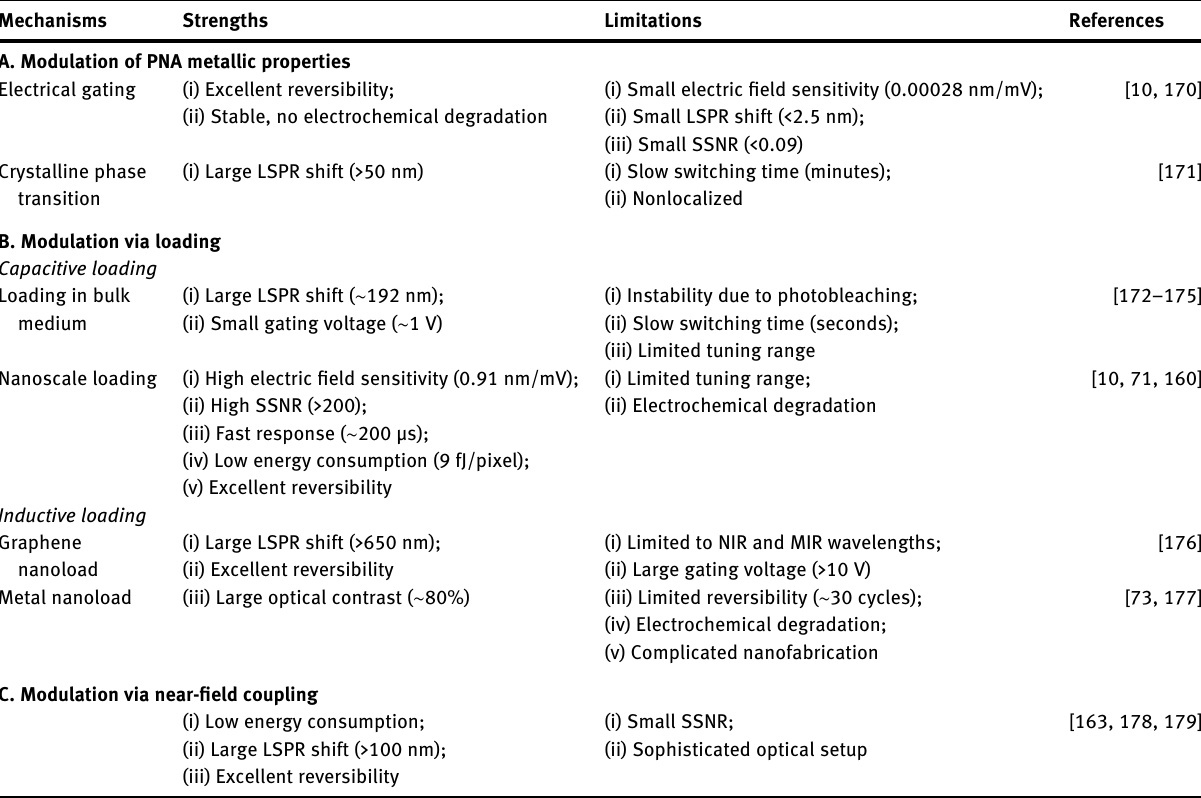
Table  : Comparison of three mechanisms employed for active PNA tuning.